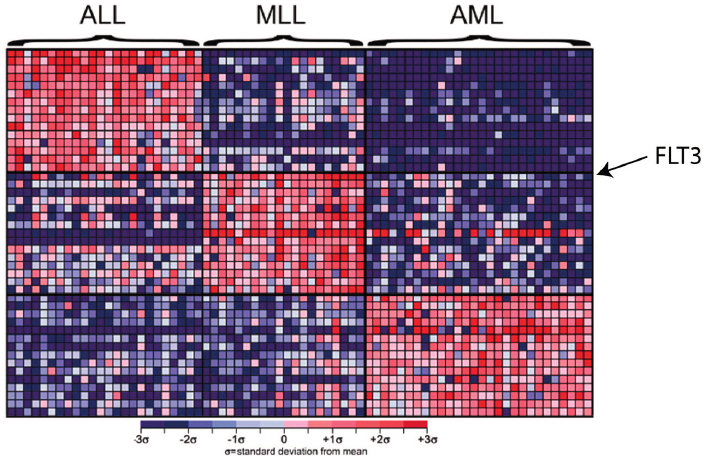
Figure 2. Diagnosis and disease classification using molecular